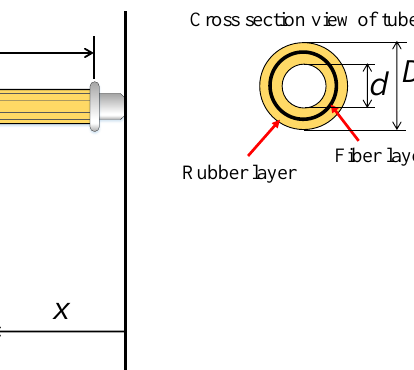
Figure 2. The schematic of the straight-fiber artificial muscle (SFPAM).